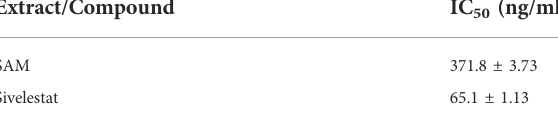
TABLE 5 IC 50 values of S. apetala fruit extract and Sivelestat.